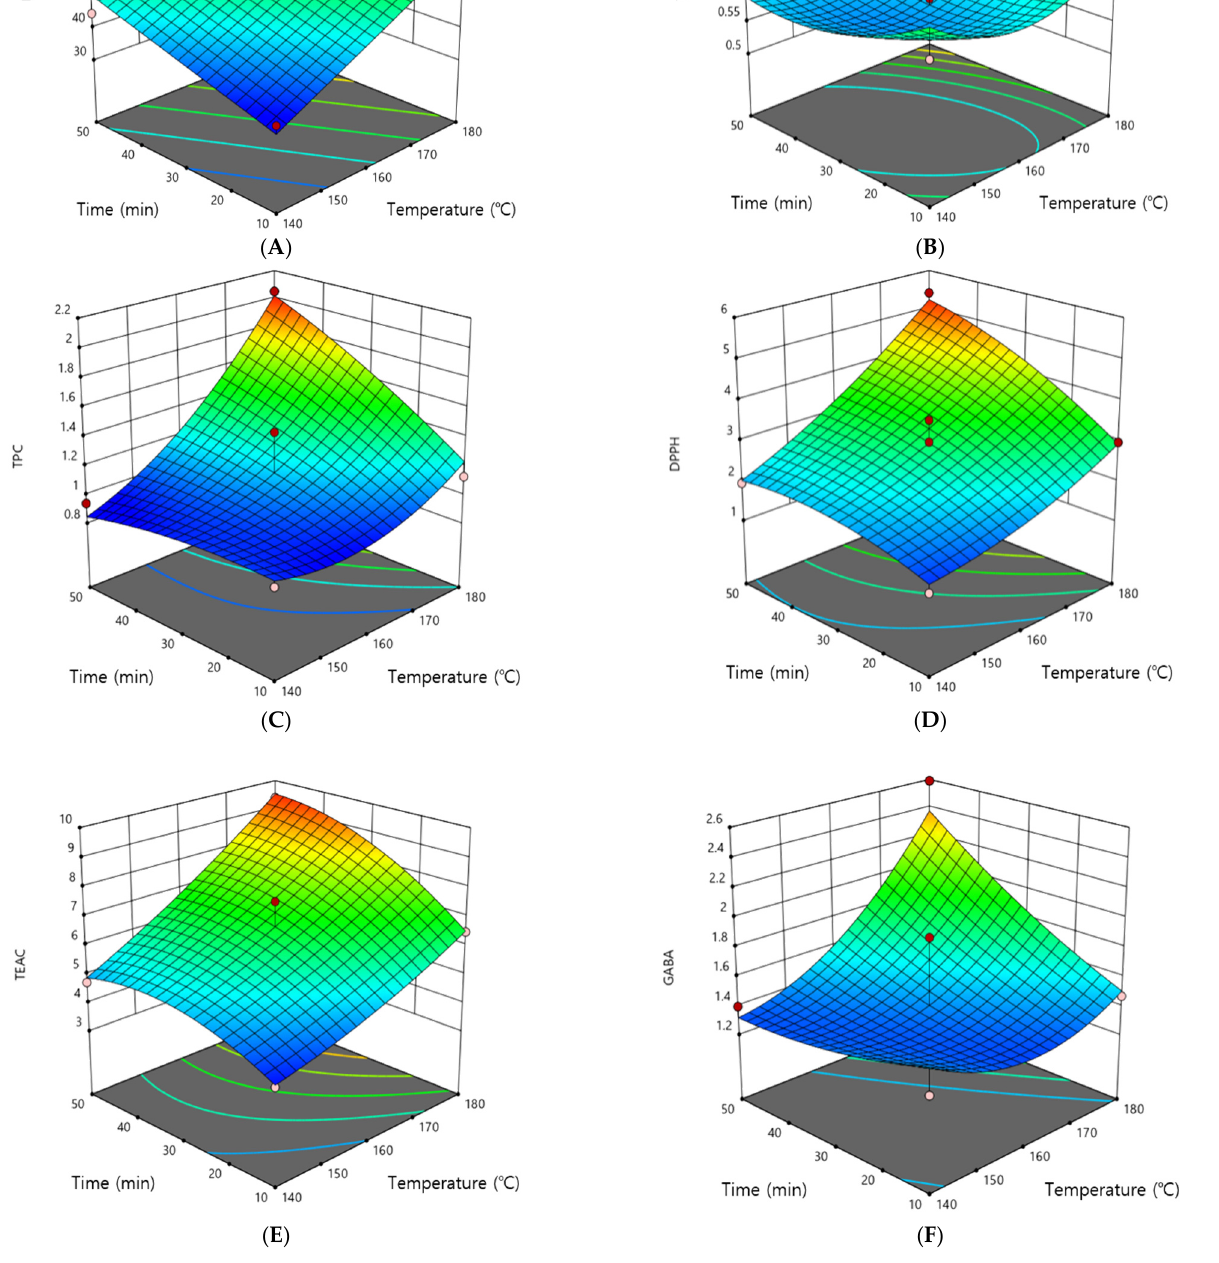
Figure 1. Three-dimensional response surface plots for BI, TFC, TPC, DPPH, TEAC, and GABA. ( A ) BI, browning index; ( B ) TFC, total flavonoid content (mg CE/g); ( C ) TPC, total phenolic content (mg GE/g); ( D ) DPPH, 2,2-diphenyl-1-picrylhydrazyl radical scavenging activity ( μ M TE/g); ( E ) TEAC, Trolox equivalent antioxidant capacity (mM TE/g); ( F ) GABA, gamma-amino butyric acid (mg/g).